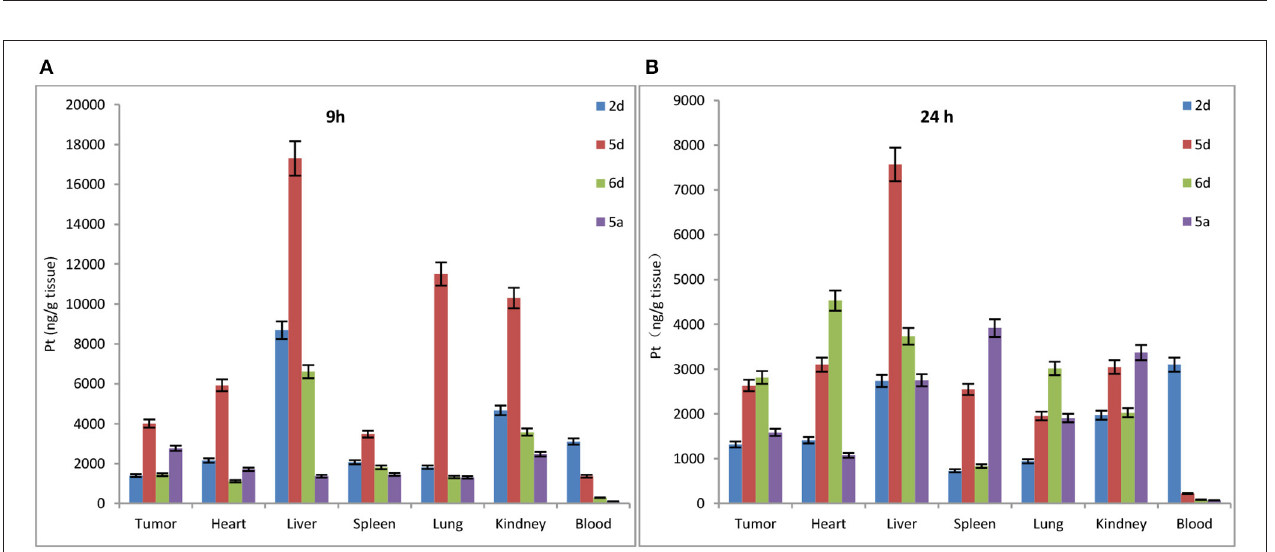
FIGURE 9 | Biodistribution of Rha-Pt ( 2d ), Gal-Pt ( 5d ), Glc-Pt ( 6d ), and satraplatin ( 5a ) in vivo for 9h (A) and 24h (B) .